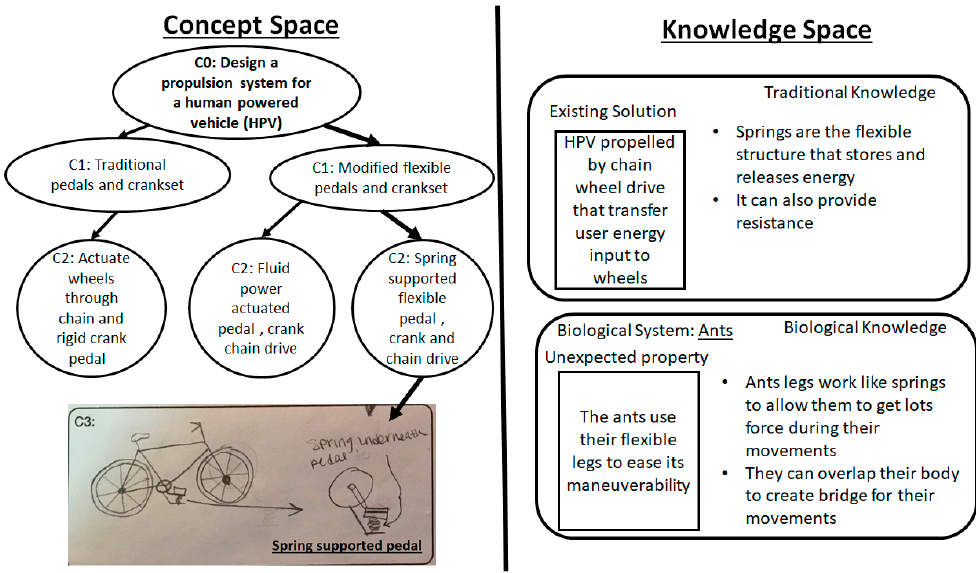
Figure 2. Evaluation of C-K theory based design process.